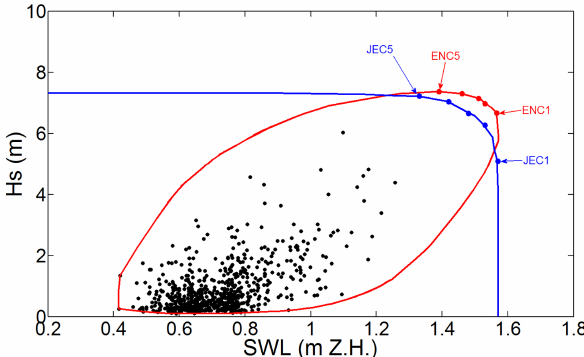
Figure 8. 100-year JEC (blue) and ENC (red). B + is the surface delineated by the tangent to the contour which does not contain the convex surface B . The tangent is a linear approximation of the true limit state function (Huseby et al.,